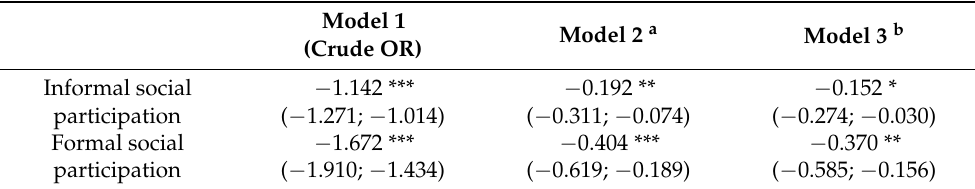
Table 2. Multiple linear regression analysis of the association between social participation and remaining